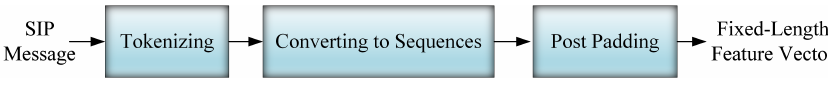
Figure 1. Feature extraction